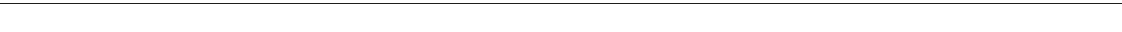
Fig. 6 TFE3 and TFEB increase TMEM55B expression to cluster lysosomes during starvation. a – c ARPE-19 cells were infected with adenovirus expressing TFE3-S321A-Myc, TFEB-S211A-FLAG, or null virus for 36 h. a Relative quantitative real-time PCR analysis of TMEM55B mRNA transcript levels (mean ± s.e. m. of the RNA fold change of indicated TMEM55B normalized to GAPDH mRNA, n = 4). b Representative immunoblot of lysates from TFE3-S321A-Myc and TFEB-S211A-FLAG expressing cells. c Quanti fi cation of TMEM55B protein levels. d Control MEFs untreated or starved in EBSS for 4 h. Cells were fi xed, permeabilized, and immunostained with antibodies against TFE3. e – g Relative quantitative real-time PCR analysis of e MCOLN1, f TMEM55B and g TMEM55A mRNA transcript levels from null- or TFE3/TFEB knockout MEFs, untreated or starved in EBSS for 4 h (mean ± s.e.m. of the RNA fold change of indicated TMEM55B normalized to GAPDH) n = 6 from three independent experiments. h HeLa cells stably expressing control or TFEB shRNAs were starved in EBSS for 4 h. Cells were fi xed, permeabilized, and immunostained with antibodies against LAMP-1. i HeLa cells expressing control, TMEM55B, and JIP4 RNAis were starved in EBSS for 4 h. Cells were fi xed, permeabilized, and immunostained with antibodies against LAMP-1. j Quanti fi cation of lysosome distribution, percentage of total fl uorescence signal detected > 15 μ m from nuclear rim. Quanti fi ed results are presented as mean ± s.e.m. using